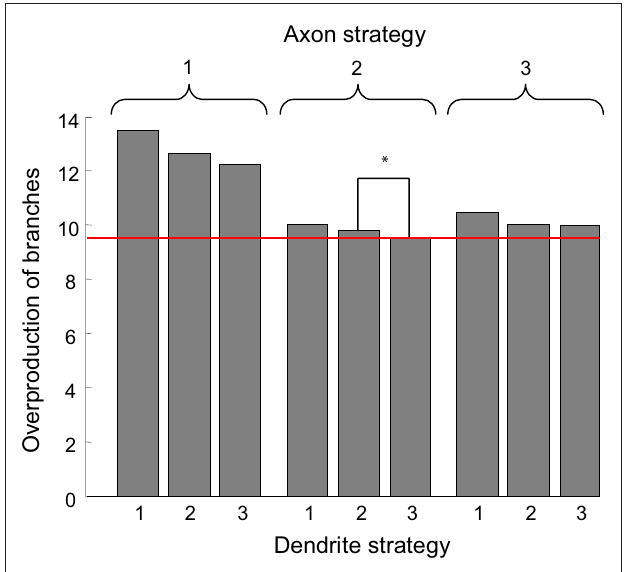
FIGURE 5 | The average overproduction of branches for nine combinations of branching strategies used by axons and dendrites. The overproduction of branches is the ratio of the number of branches formed to the minimal number of branches required to establish the topographic map. We then average this value over the performance boundaries from Figure 4 . The most effective is the combination of branching Strategy 2 for axons and Strategy 3 for dendrites (level shown by red line). The statistical difference between the optimal combination of branching strategies and the second best combination (shown by the star) corresponds to p -value less than 10 − 4 .